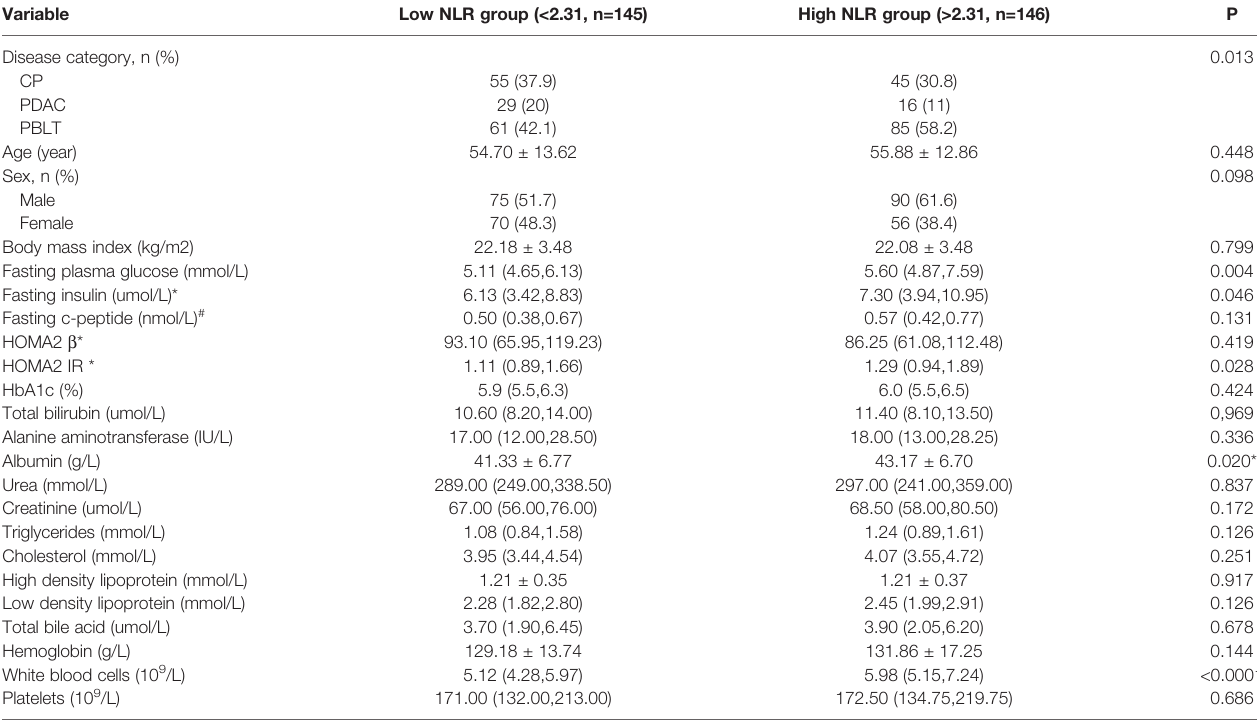
TABLE 3 | Characteristic of the subjects strati fi ed by values of the NLR. Variable Low NLR group (<2.31, n=145) Disease category, n